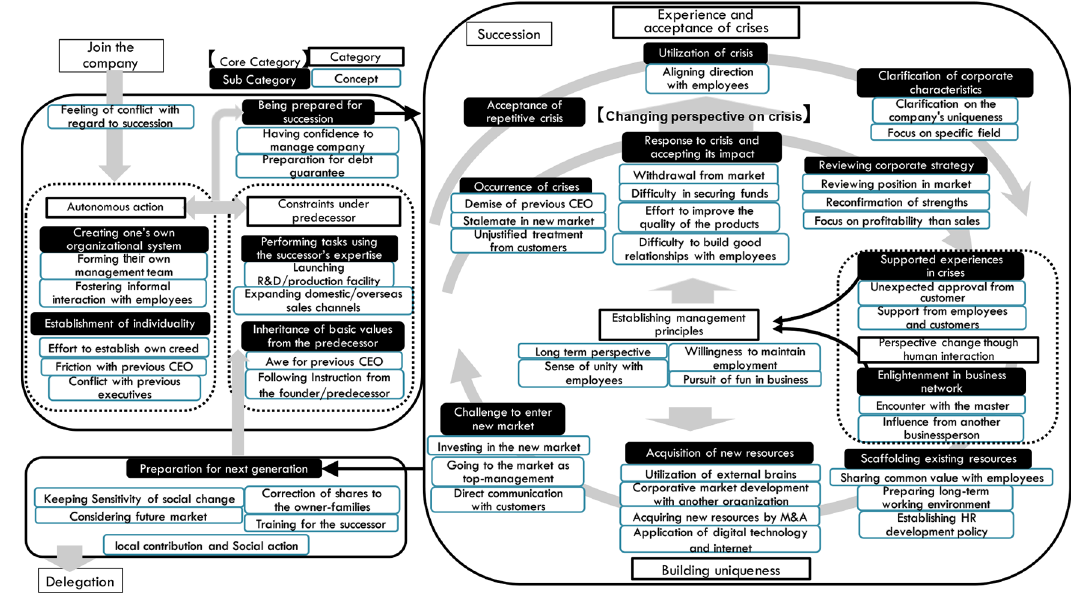
Figure 2. Analysis result diagram generated in this